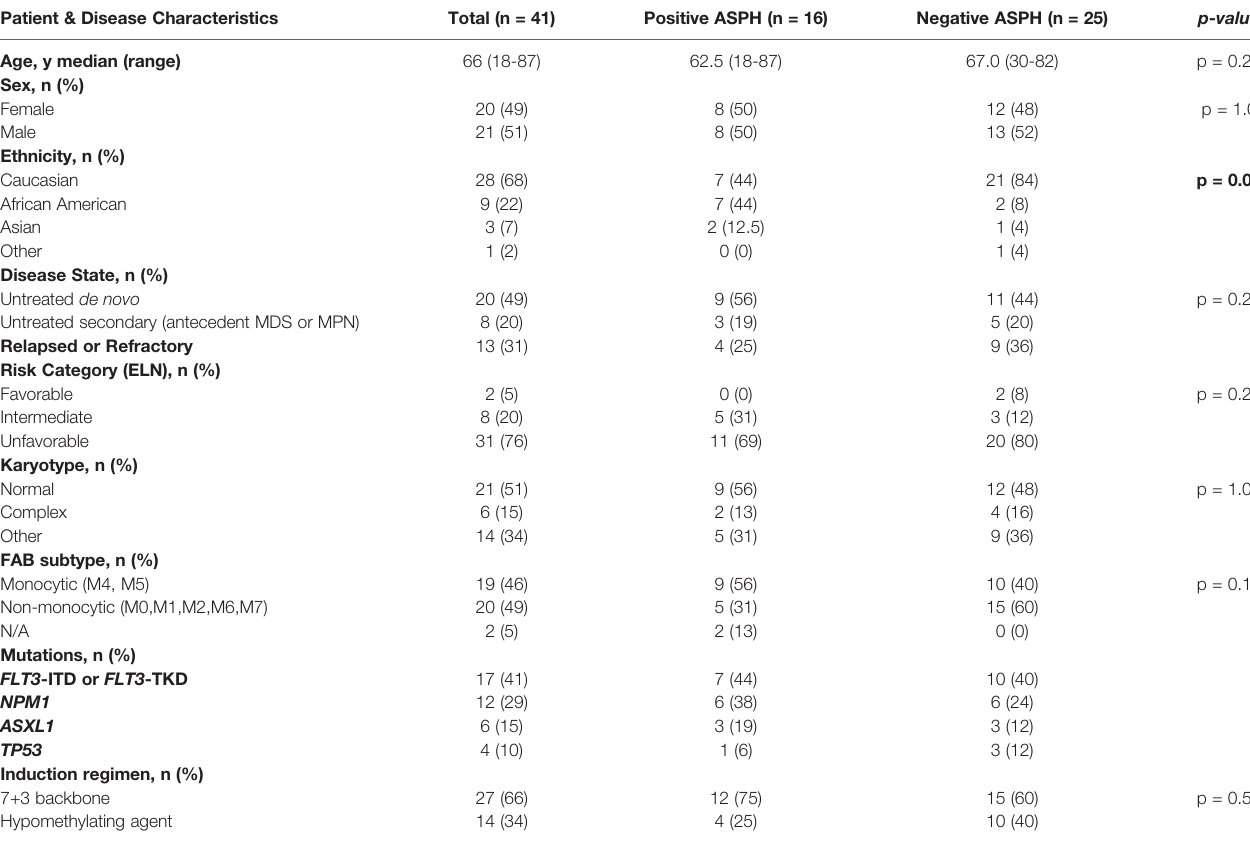
TABLE 1 | Patient and disease